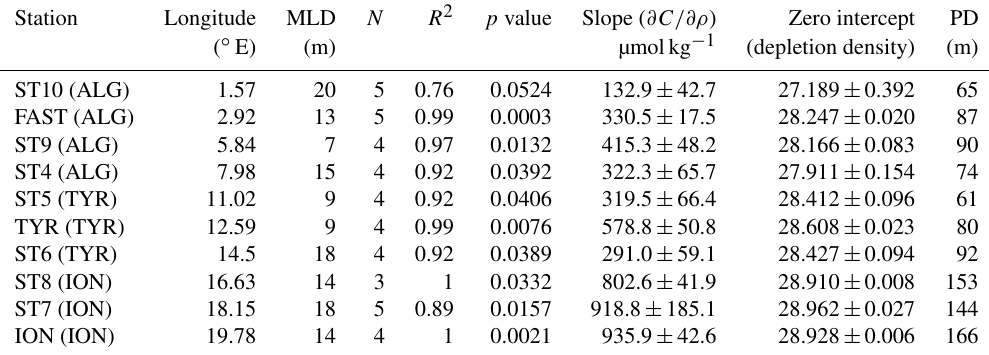
Table 1. Results of the linear fitting computed for each station between phosphate concentration and density at the layer showing the maximum gradient, indicative of the phosphacline. The phosphacline depth (PD) corresponds to the depletion density depth. Note that for ST10 the linear fitting was not significant ( p > 0 . 05), and obtained parameters (slope and zero intercept) must be taken with caution. Station Longitude MLD N R 2 p value Slope ( ∂C/∂ρ ) Zero intercept PD ( ◦ E) (m) µmolkg − 1 (depletion density) (m) ST10